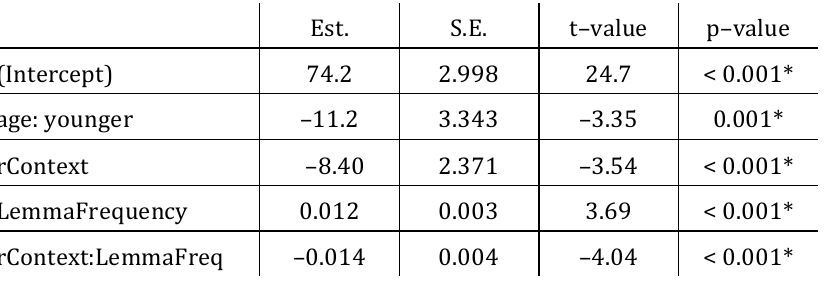
Table 7: Mixed-effects model for High